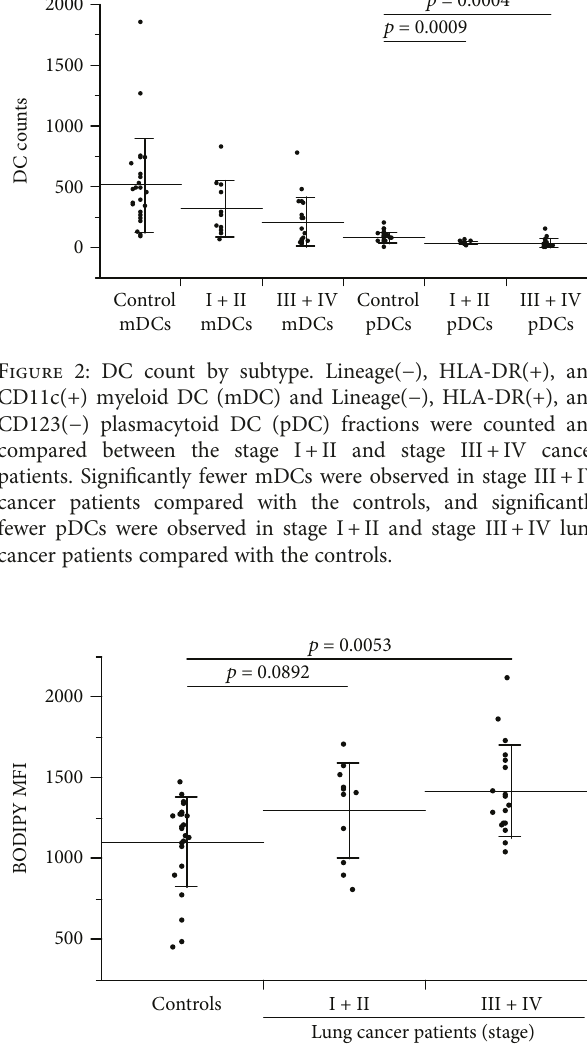
Figure 3: BODIPY 650/665 fl uorescence intensity in peripheral blood DCs. The BODIPY 650/665 mean fl uorescence intensity of HLA-DR(+) and Lineage-1( − ) DC fractions was assessed in lung cancer patients according to clinical stages. A signi fi cant di ff erence was observed between the stage III+ IV lung cancer patients and the controls ( p = 0 0053